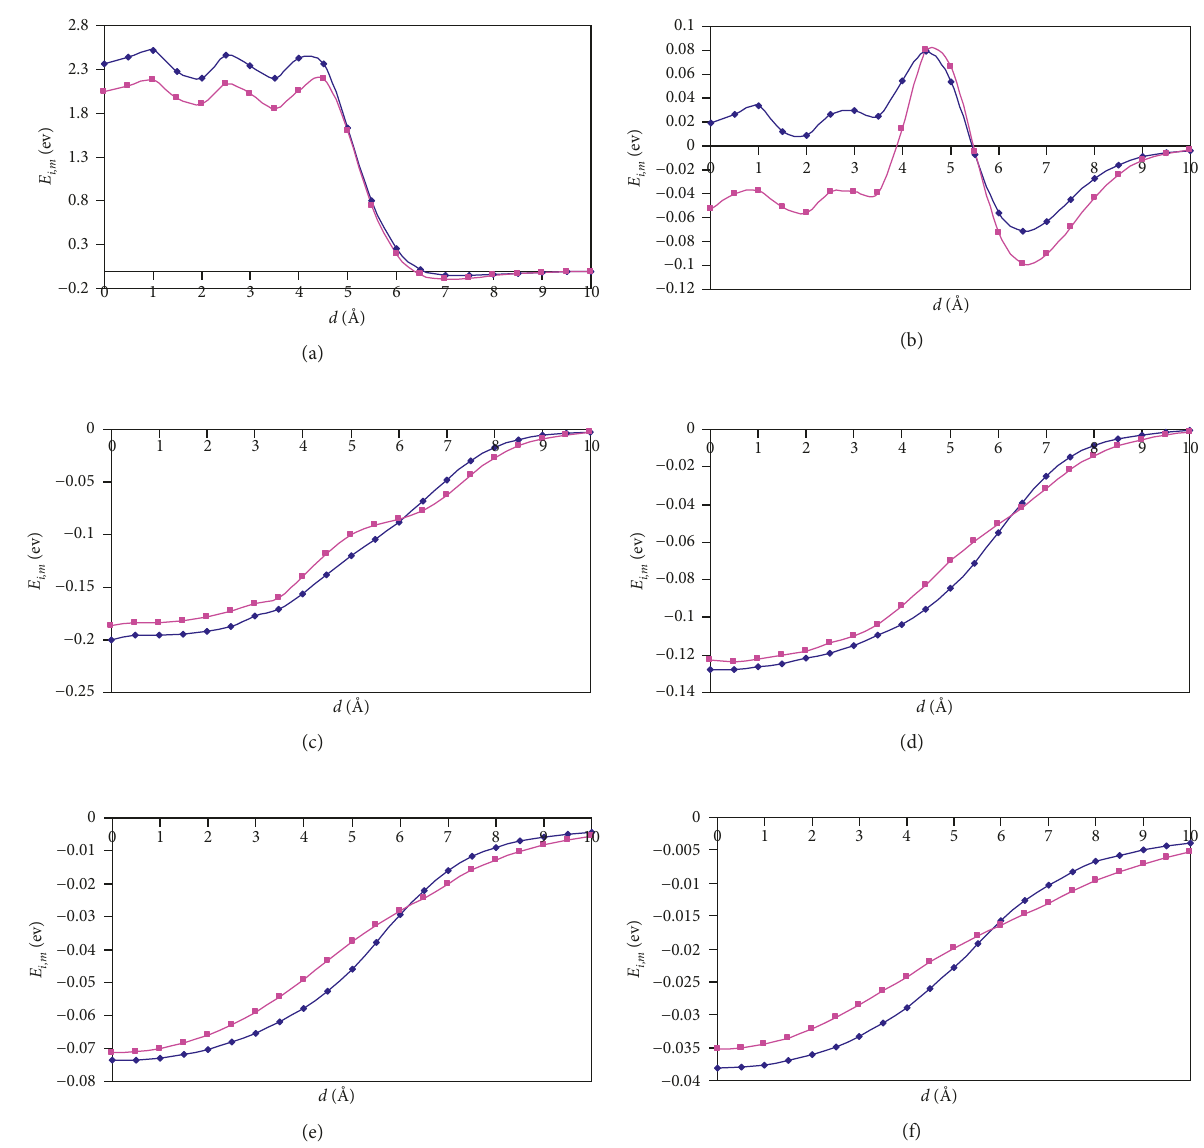
Figure 2: Interaction energies ( E � 1–10) for the insertion of a hydrogen molecule into (3,3)–(8,8) SWCNTs perpendicularly ( ◆ , blue) i,m , m and in parallel ( ■ , magenta) with the nanotube axis as a function of d . (a) (3,3) SWCNT. (b) (4,4) SWCNT. (c) (5,5) SWCNT. (d) (6,6) SWCNT. (e) (7,7) SWCNT. (f) (8,8)